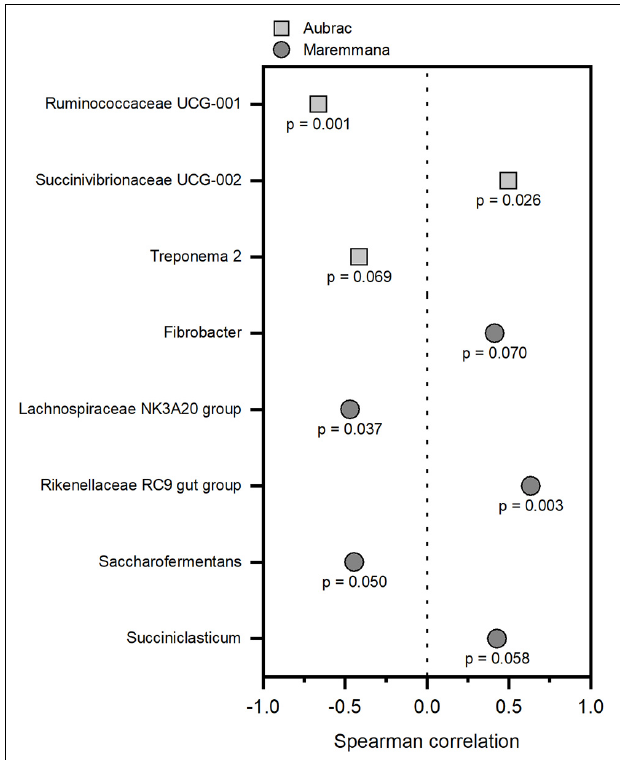
FIGURE 4 | Correlations between the rumen bacteria and the average daily weight gain of the Aubrac cattle and the Maremmana cattle. Only significant correlations ( p < 0.1) were reported. Correlations were calculated independently for each breed, and only the genera with a relative abundance of 1%, or higher, in at least one sample were